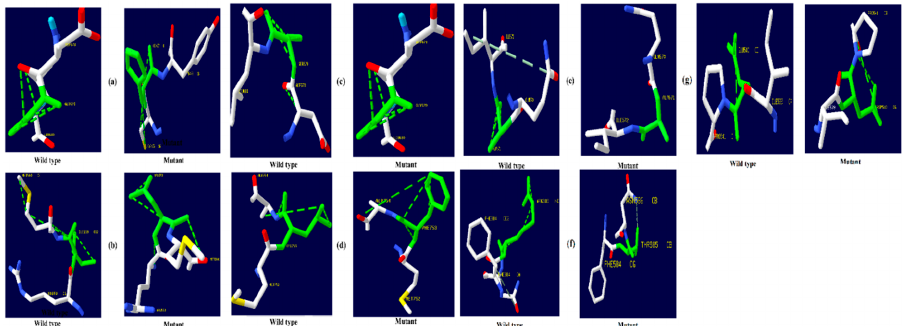
Figure 5. NR3C1 protein hydrogen bonding results ( a ) R477H, ( b ) I559N, ( c ) G679S, ( d ) L753F, ( e ) V571A, ( f ) R23T, and ( g ) E22D.